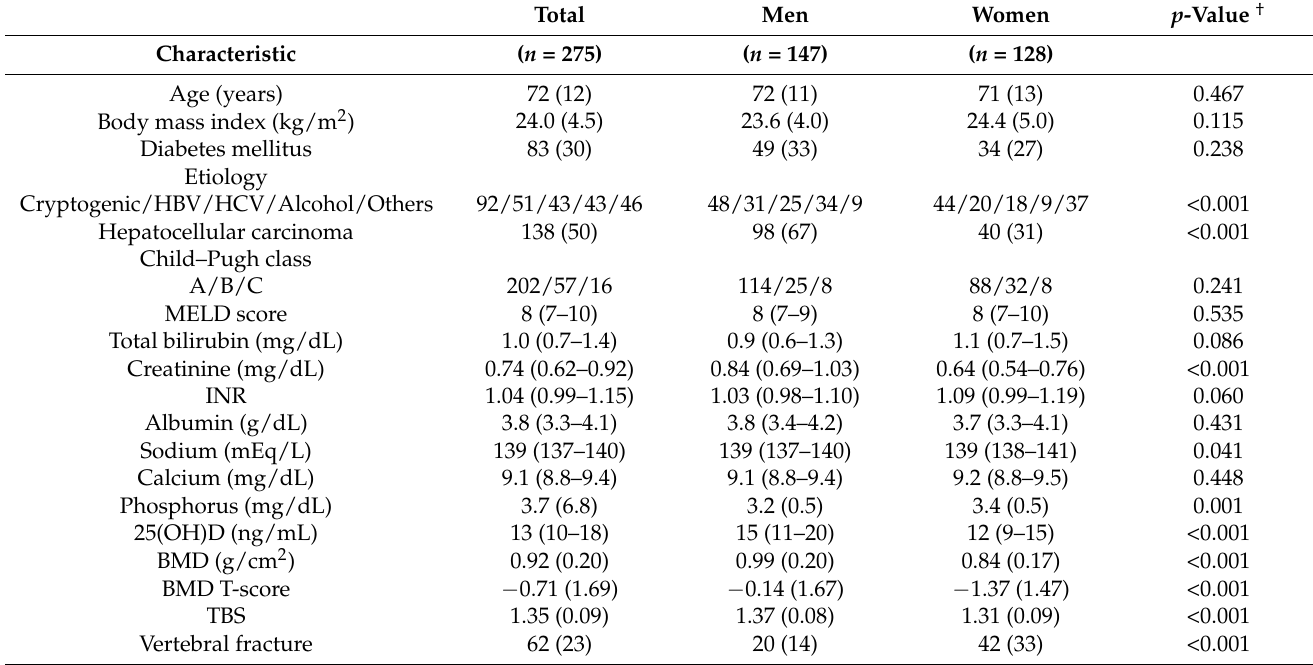
Table 1. Comparison of clinical characteristics between male and female